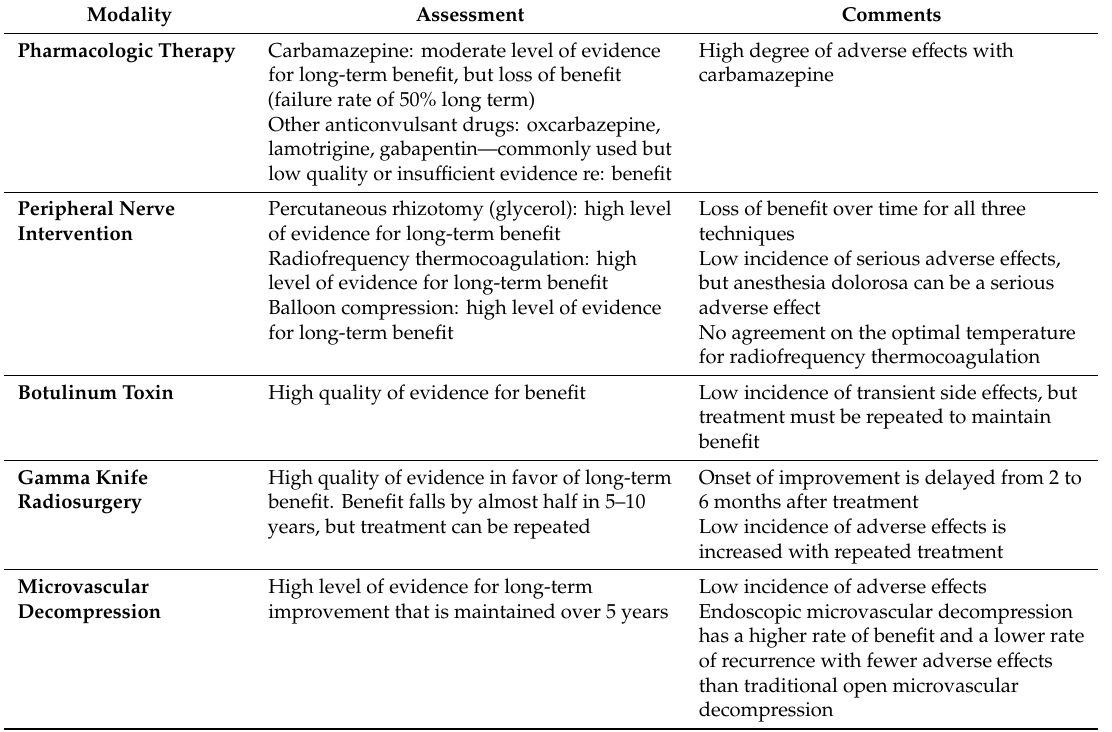
Table 2. Summary of commonly used therapies for trigeminal neuralgia.